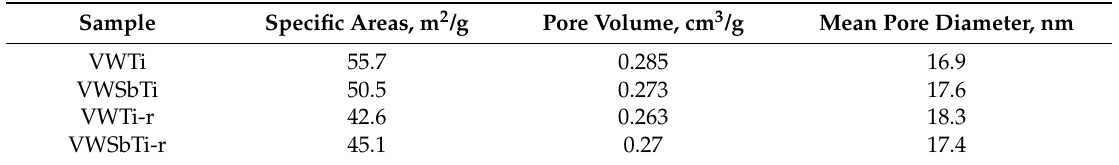
Table 2. Pore structure of the